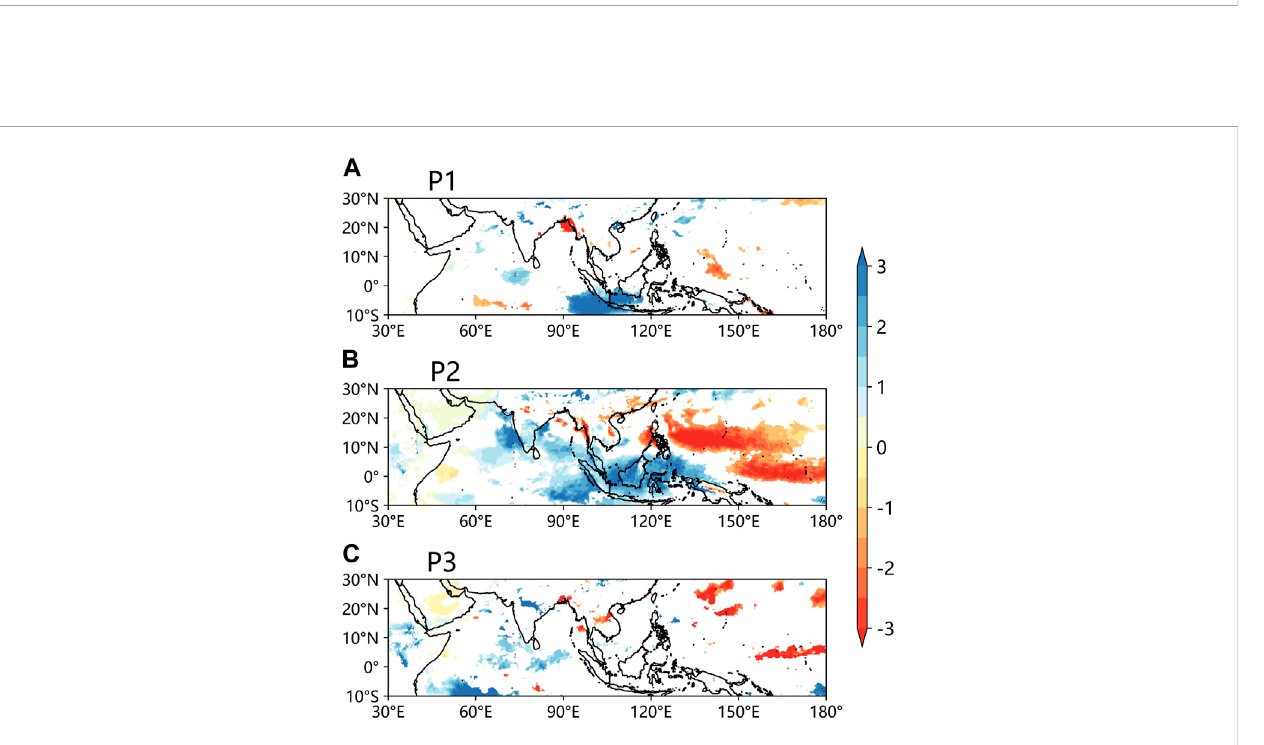
FIGURE 10 Regressioncoef fi cientofthepreviousautumnIODindexprojectedtotheprecipitationanomalies(shadows;Unit:mm)inthesummerduring (A) P1, (B) P2, and (C) P3.